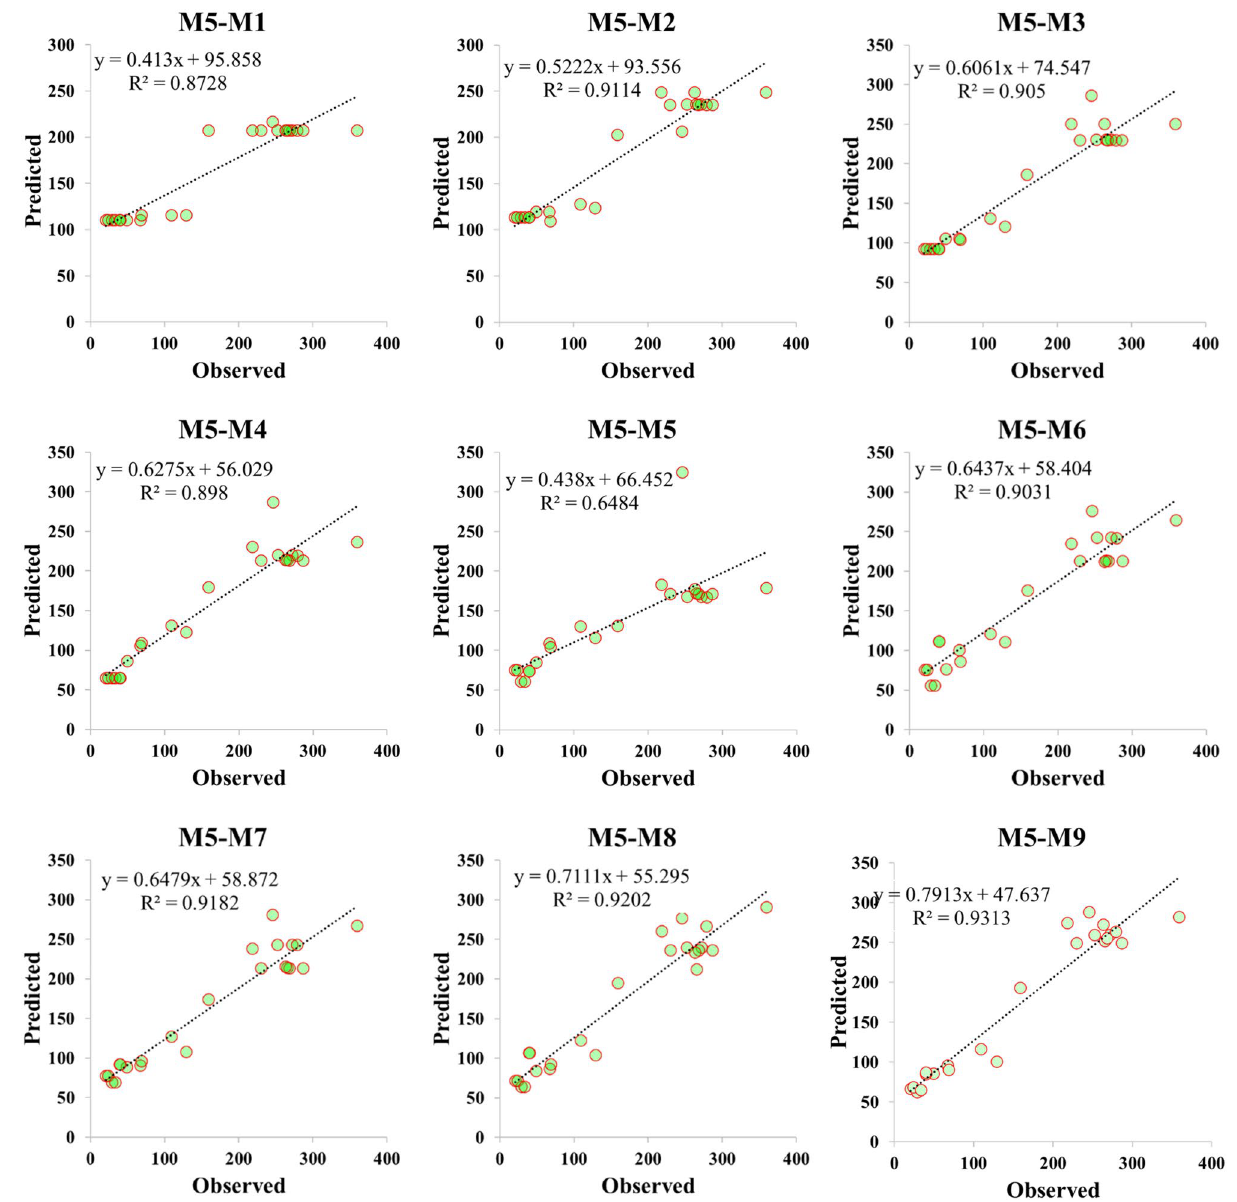
Figure 4. Scatter plot presentation of M5 prediction model over the testing modeling